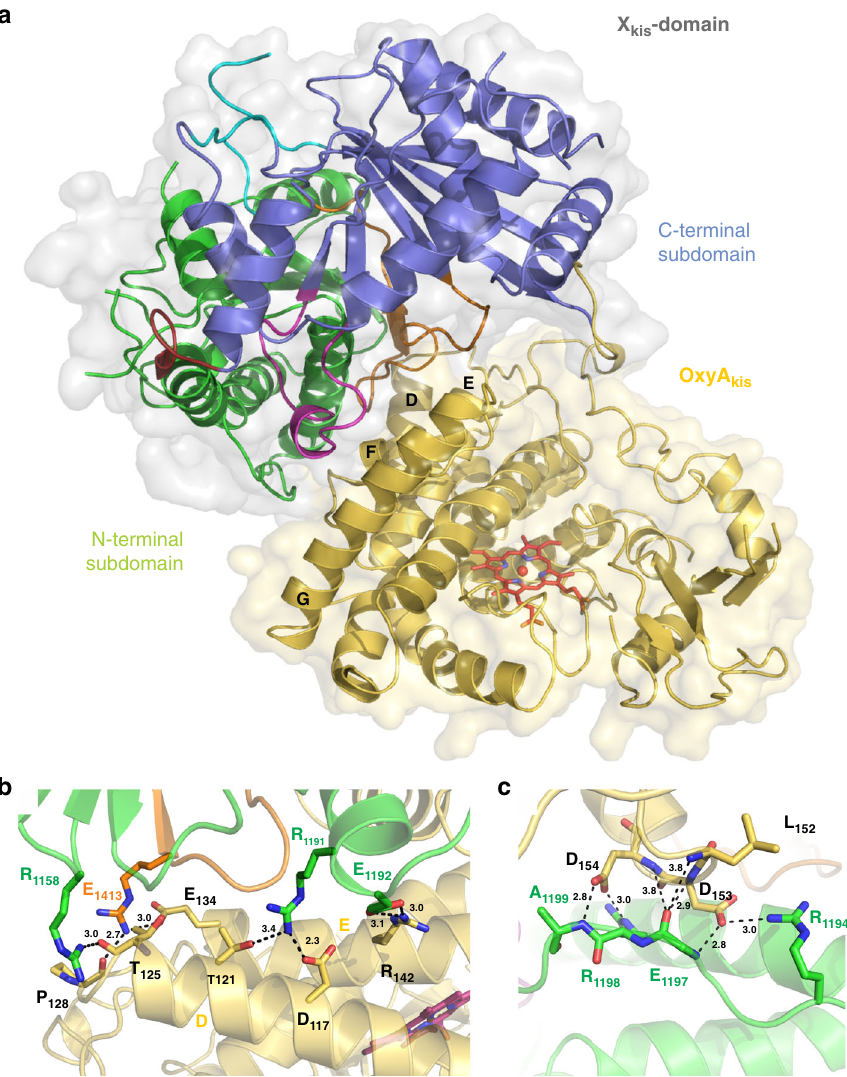
Fig. 5 Structure of OxyA kis /X kis complex. a Structure of the complex, showing the X-domain bound above the P450 via the D/E and F/G helices (X-domain N-terminal subdomain shown in green, C-terminal subdomain shown in blue, crossover regions shown in pink and orange; loops that close the typical acceptor site shown in cyan; P450 shown in yellow, with the active site heme moiety shown in sticks and helices D-G labelled). b Hydrogen bonding and salt bridge interactions between the X-domain and D-E helices of OxyA kis (coloured as in a , side chains shown as sticks). c Hydrogen bonding and salt bridge interactions between the X-domain and PxDD motif at the start of helix F in OxyA kis (coloured as in a , side chains shown as